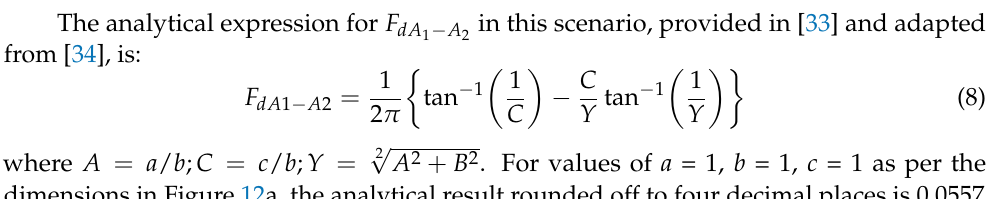
Figure 12. View factor between a differential planar element to rectangle in plane 90 ◦ to plane of element as shown in ( a ) with the corresponding calculation in ( b